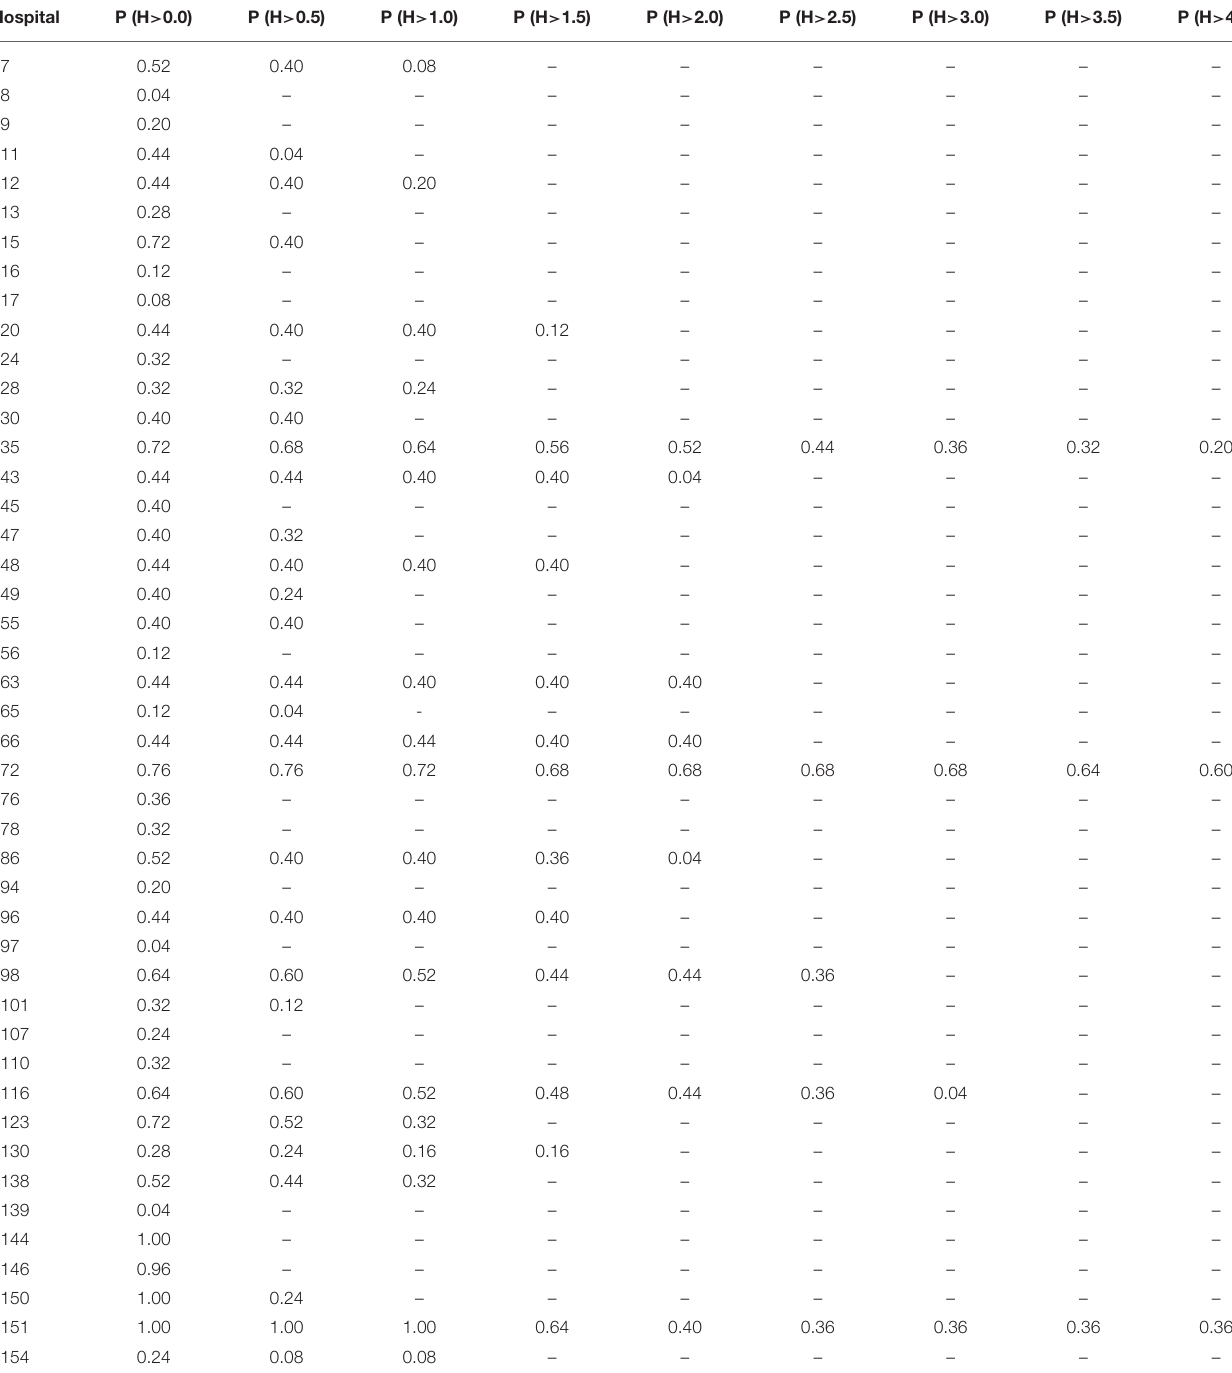
TABLE 5 | Complementary cumulative distribution functions of flood level (m) at hospitals.